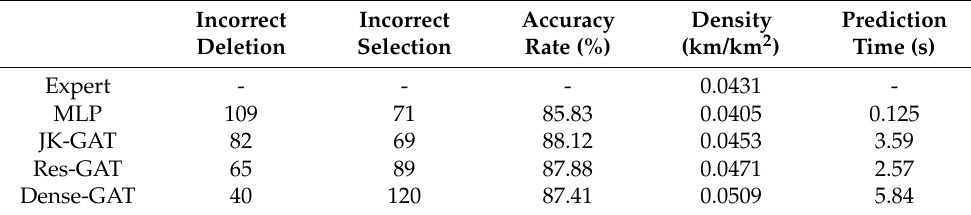
Table 3. Accuracy rate, line density, and prediction time of different models calculated using the Python programming